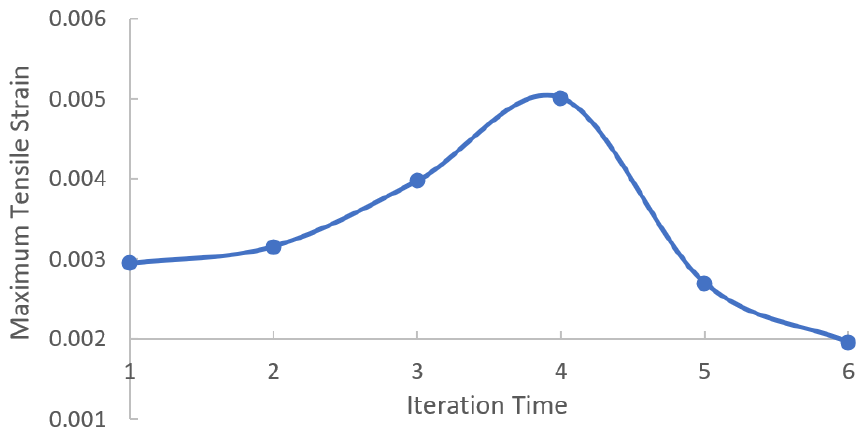
Figure 8. Maximum strain in the breakout tip in the process of breakouts.